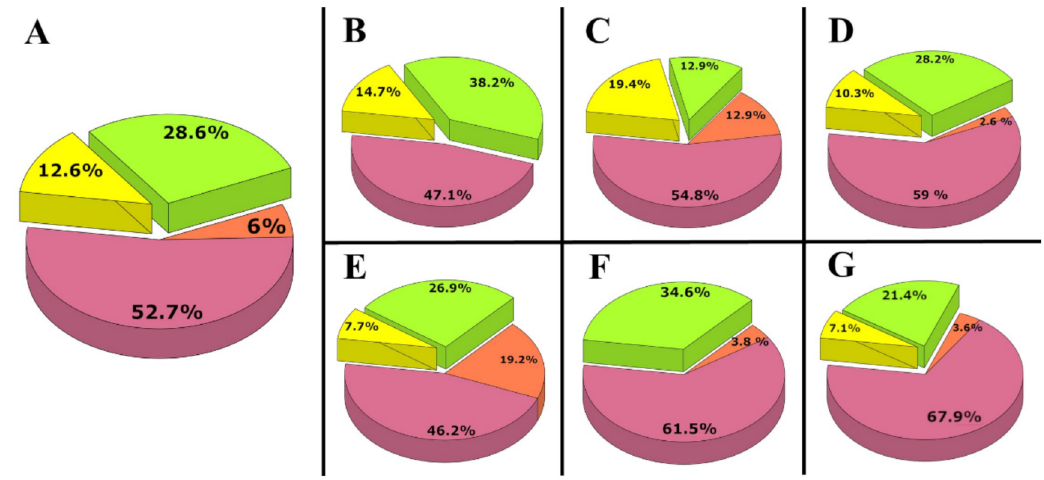
Figure 2. The phylogeographic origin of the ConqC maternal lineages from different cemeteries. Data are summarized from Figure S1 and from a previous study [6]. West Eurasian haplogroups (Hgs) are marked with pink, east Eurasian Hgs are marked with yellow, Eurasian Hgs are marked with green and Caucasus–Middle East Hgs are marked with brown. ( A ) Distribution of the merged data of 182 Hungarian commoner samples from all cemeteries. ( B – G ) The phylogeographic distribution of the maternal lineages from individual cemeteries: ( B ) Homokm é gy-Sz é kes (n = 34); ( C ) Püspöklad á ny- Eperjesvölgy (n = 31); ( D ) S á rr é tudvari-H í z ó föld (n = 39); ( E ) Ibr á ny-Esb ó halom (n = 26); ( F ) Magyarhomorog-K ó nyadomb (n = 26, with samples taken just from the commoner part); ( G ) Vörs-Papkert-B (n = 28, including all samples from this